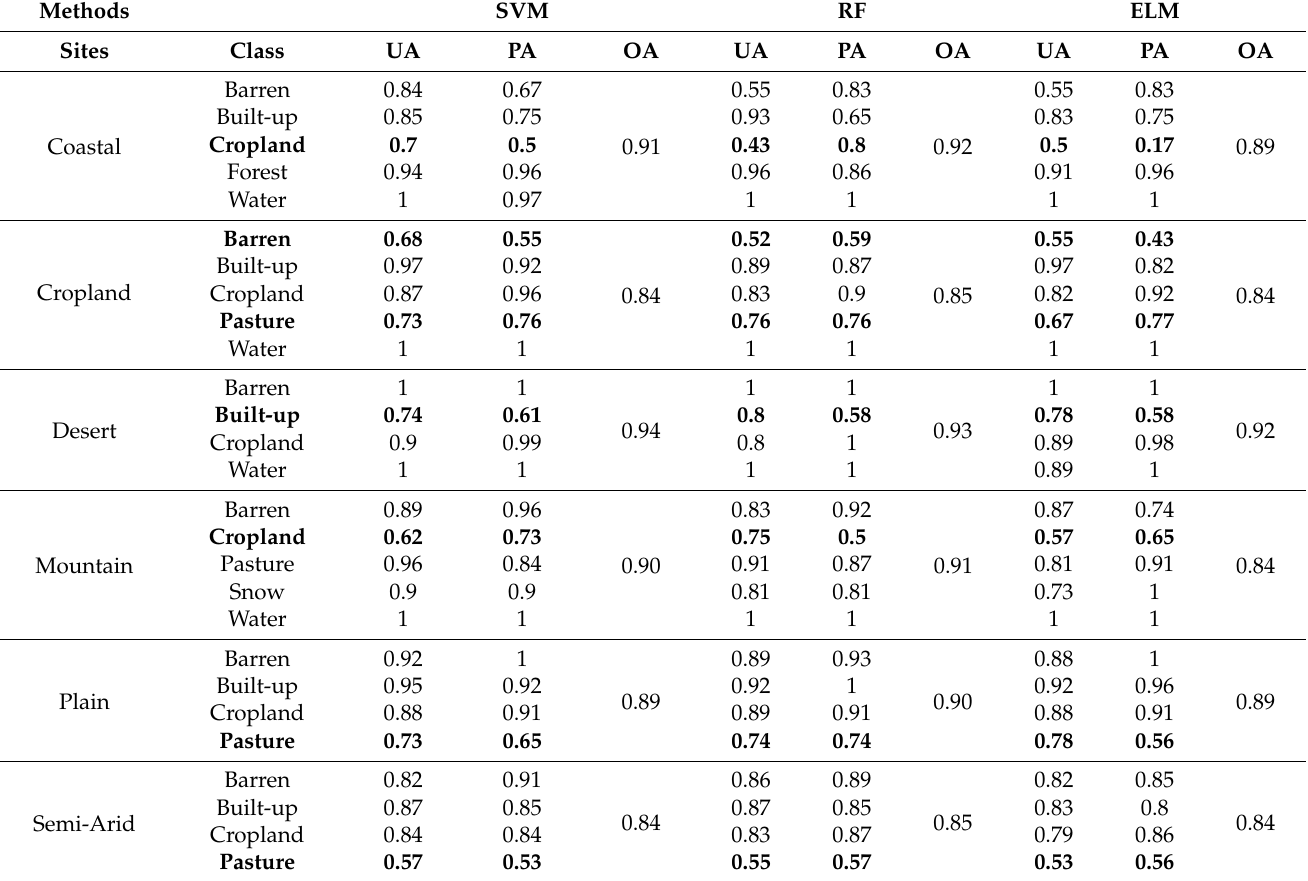
Table 5. The result of accuracy assessment methods in six different landscapes (with original GCPs). Minority classes for each landscape are